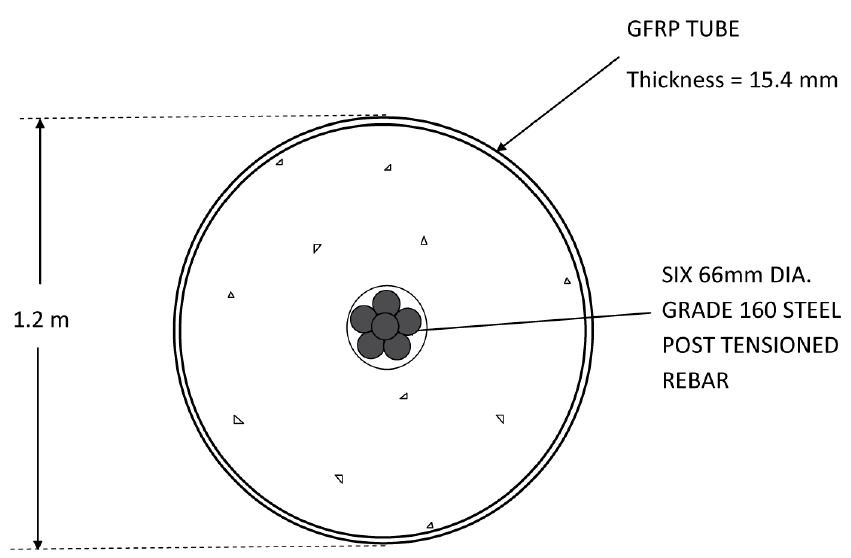
Figure 2. Column cross-section.